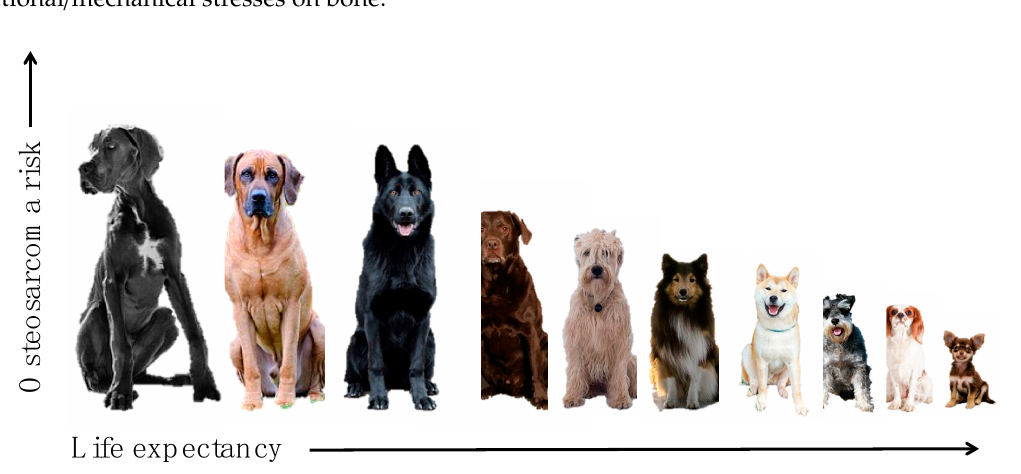
Figure 4. Risk of osteosarcoma and life expectancy are associated with body size in dogs. Large and giant breed dogs generally have shorter lifespans and an increased risk of osteosarcoma compared with smaller breed dogs.